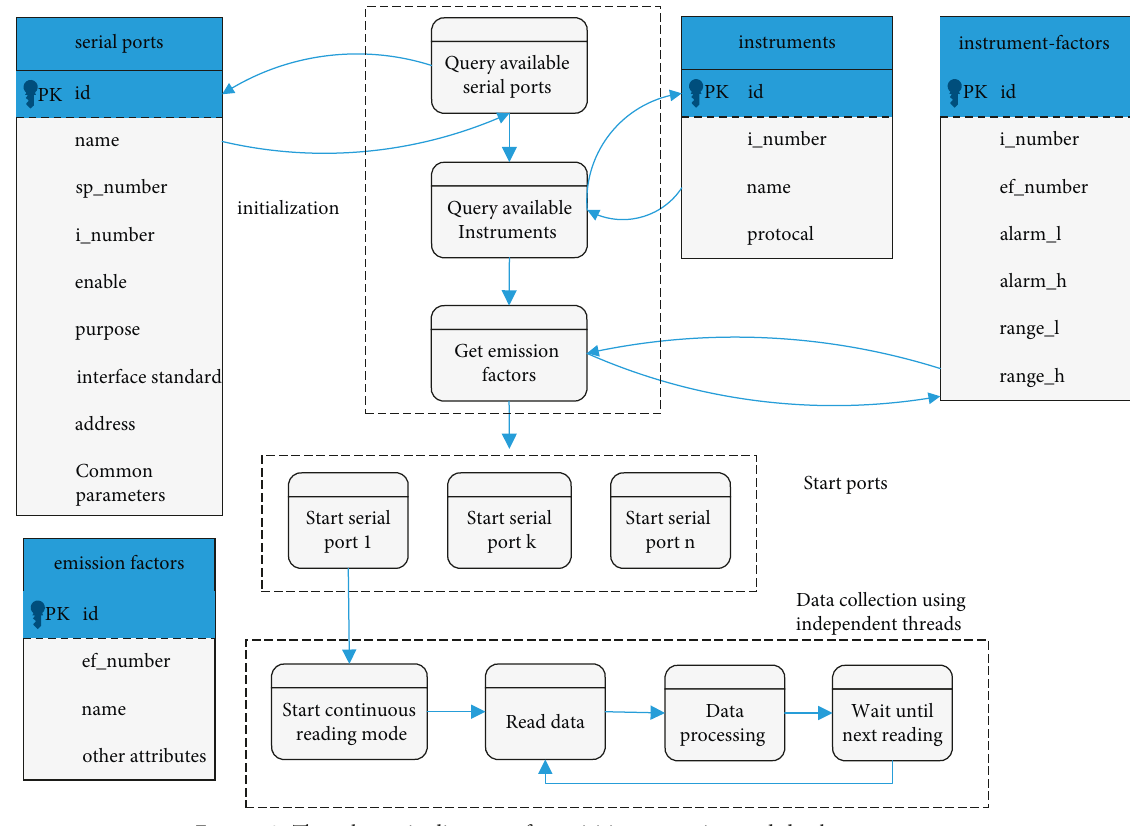
Figure 2: The schematic diagram of acquisition operation and database